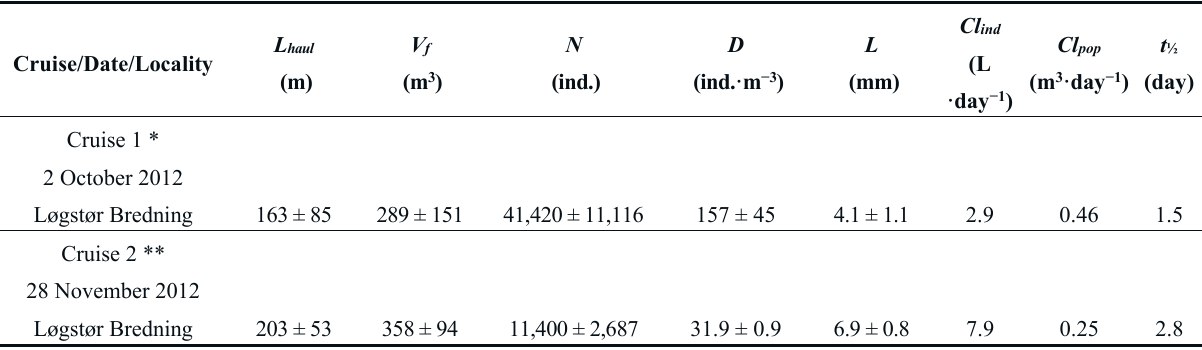
Table 2. Pleurobrachia pileus collected in Løgstør Bredning 2 October 2012. L haul = haul length; V f = volume filtered per haul; N = total number of individuals caught; D = population density; L = polar body length; Cl ind = individual clearance